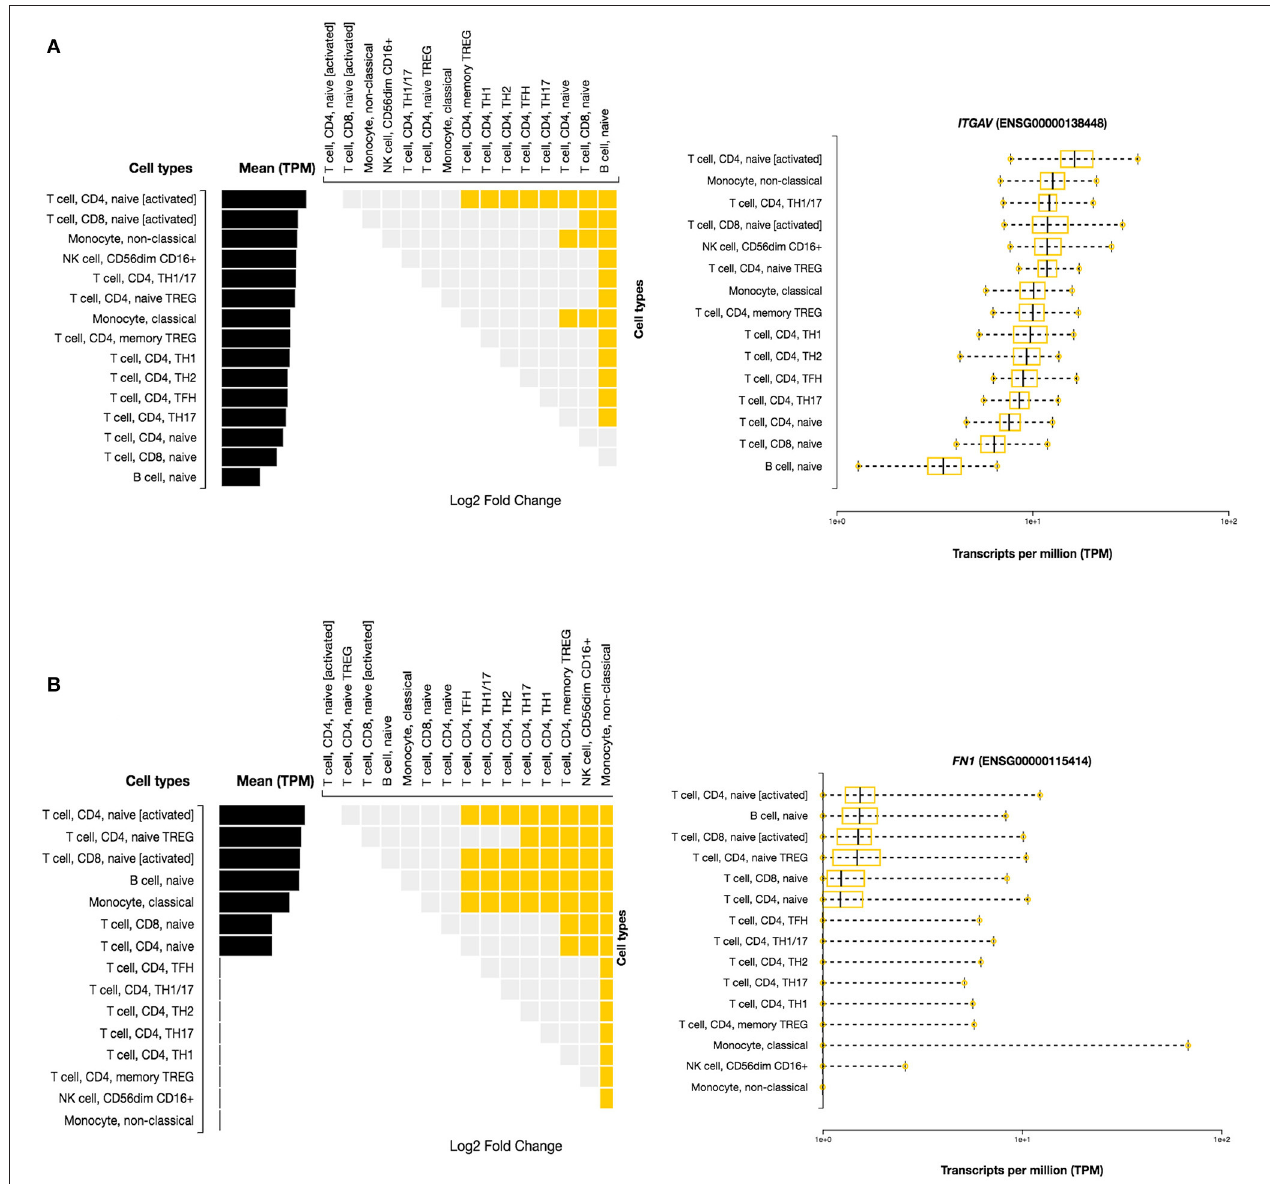
FIGURE 5 | Differential Expression of ITGAV and FN1 in DICE Database of Immune Cell-specific Gene Expression. (A) ITGAV gene is enriched significantly in naïve B-cell, CD4 + T cell types (TH17,TFH1,TFH2) immune cell types. (B) FN1 enrichment is seen in monocytes and CD4 + T cell types.